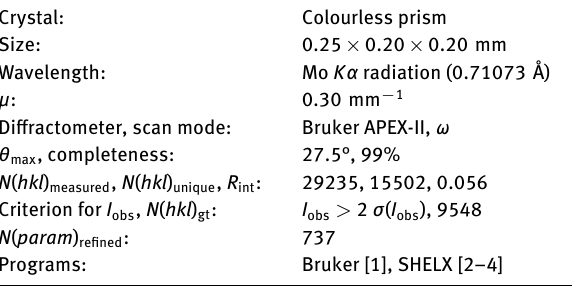
The molecular structure (asymmetric unit) is shown in the figure. Table 1 contains crystallographic data and Table 2 contains the list of the atoms including atomic coordinates and displacement parameters.